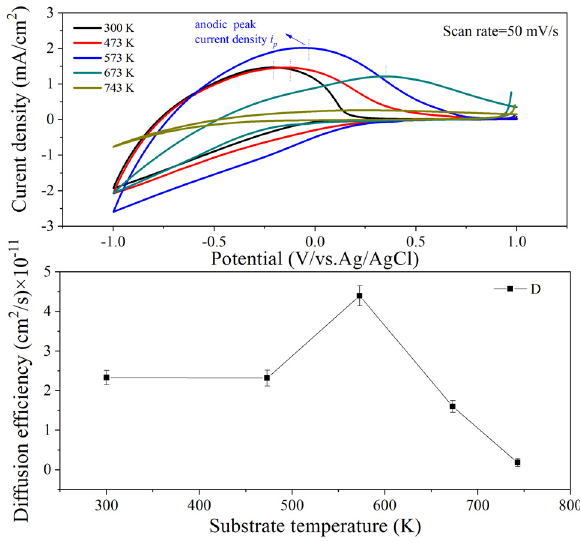
Figure 6. Cyclic voltammetry (CV) and diffusion efficiency curve of WO 3 films deposited at different substrate temperatures.